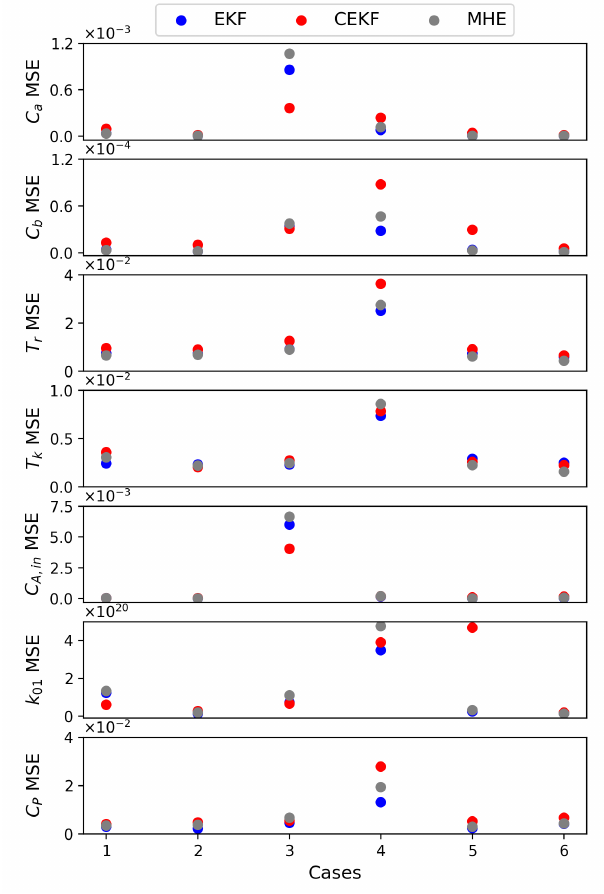
Figure 7. MSE values for estimations of the seven variables for the three approaches.